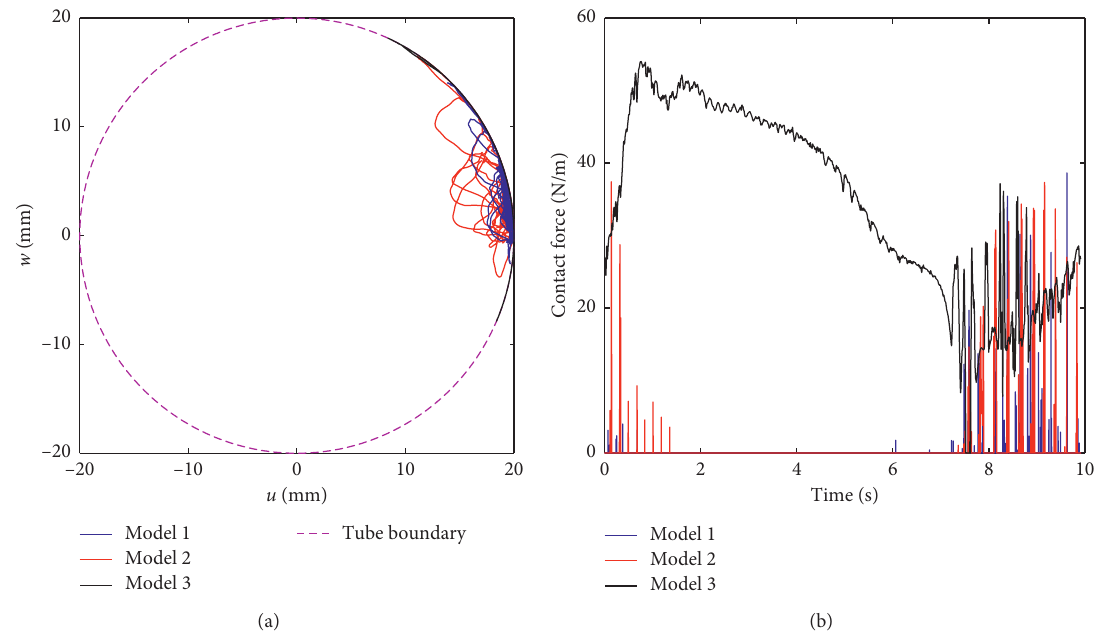
Figure 12: Simulation results of the rod node at 500m. (a) Node position. (b) Contact force between the rod and